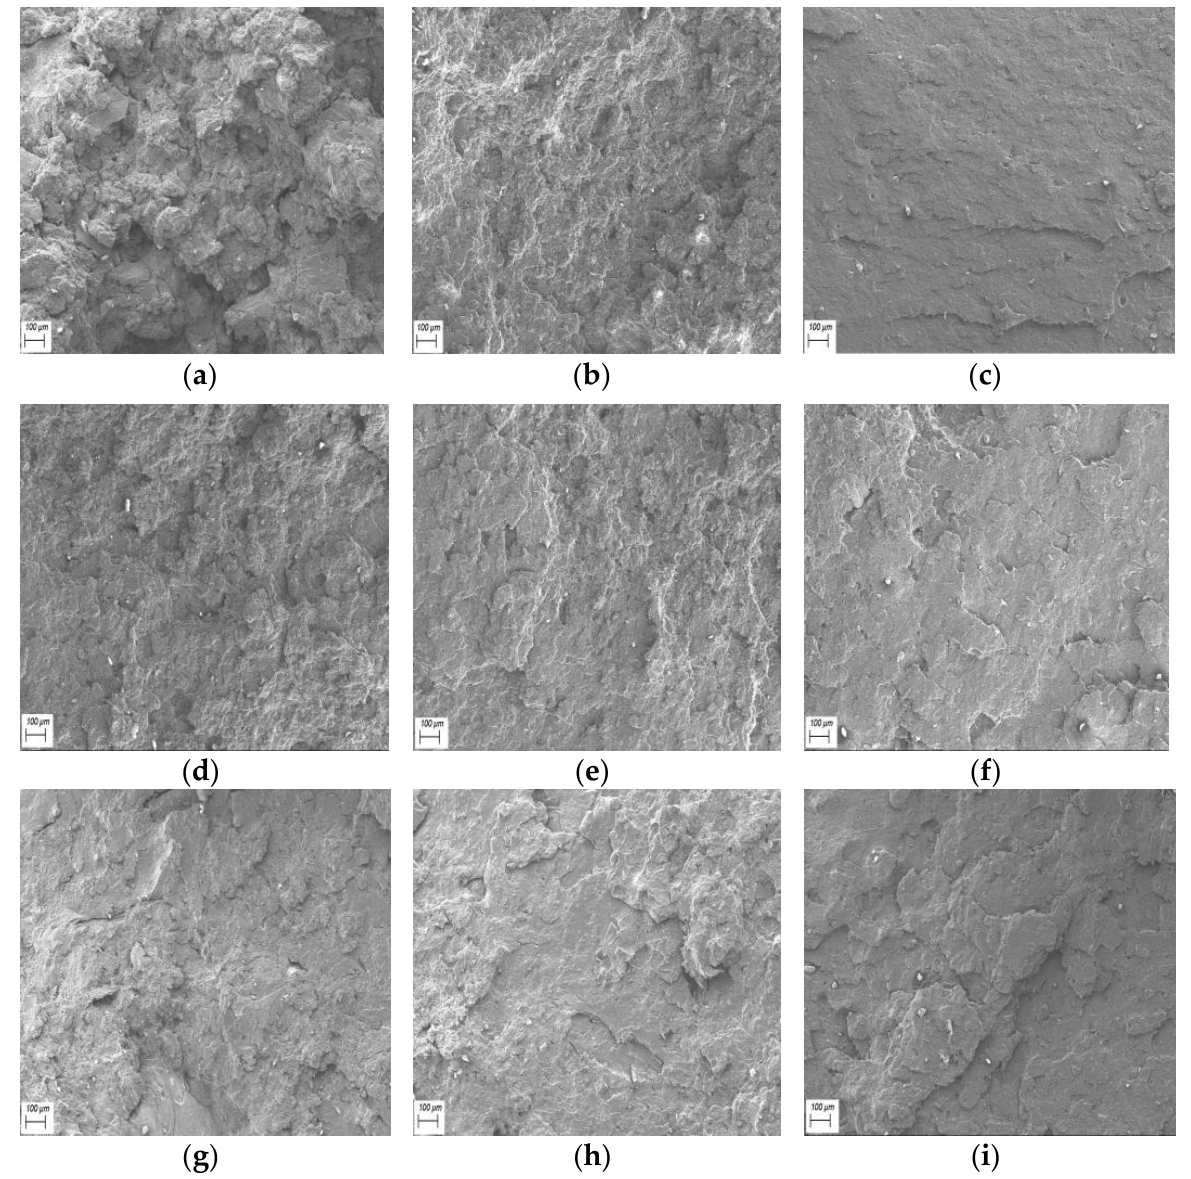
Figure 11. SEM images of RWP ( a ), S1-2%-E (50 rpm, 4.5 gpm) ( b ), 100%VR ( c ), S1-2%-E (50 rpm, 4.5 gpm) with 25 wt% ( d ), 50 wt% ( e ), and 75 wt% ( f ) VR, and untreated RWP with 25 wt% ( g ), 50 wt% ( h ), and 75 wt% ( i ) VR.